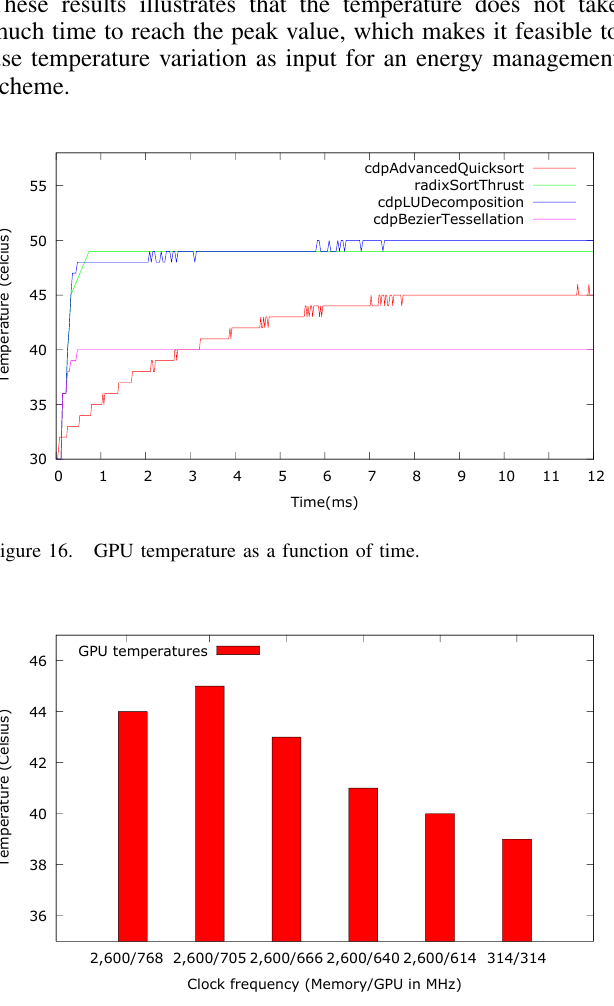
Figure 19. Render task elapsed